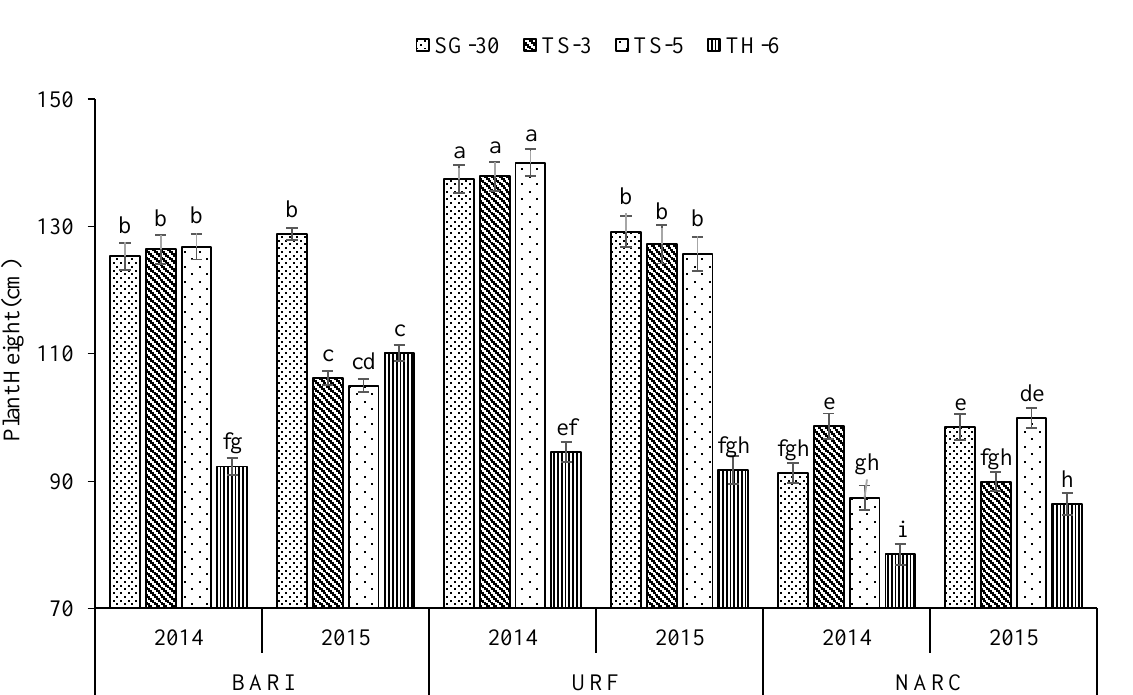
Figure 2. Plant height (cm) of four sesame cultivars at three locations during 2014 and 2015 (pooled over micronutrients). The bars indicates standard error (±SE) of mean (n = 3). All means are significantly different at p ≤ 0.05.